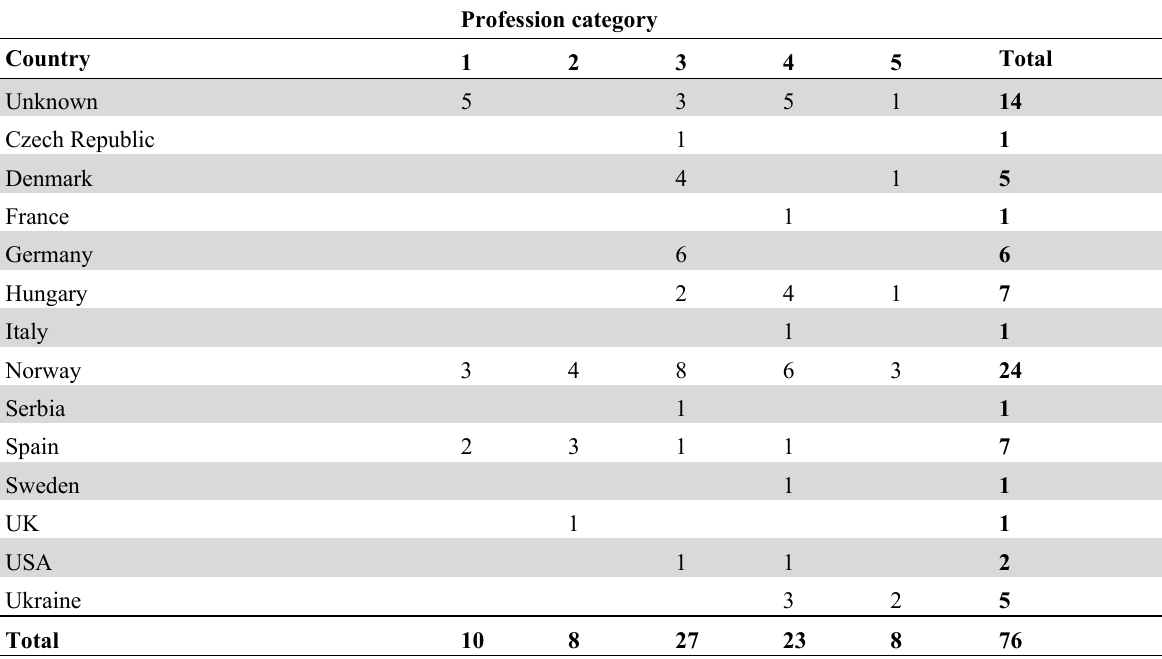
Respondents in the survey categorized per country of residence and profession. 1 = representing certified worker in the meat industry (butchery/meat cutting), 2 = other work in the meat industry, 3 = meat related research and development (e.g., uni- versity or institute), 4 = other research and development professions, and 5 = other